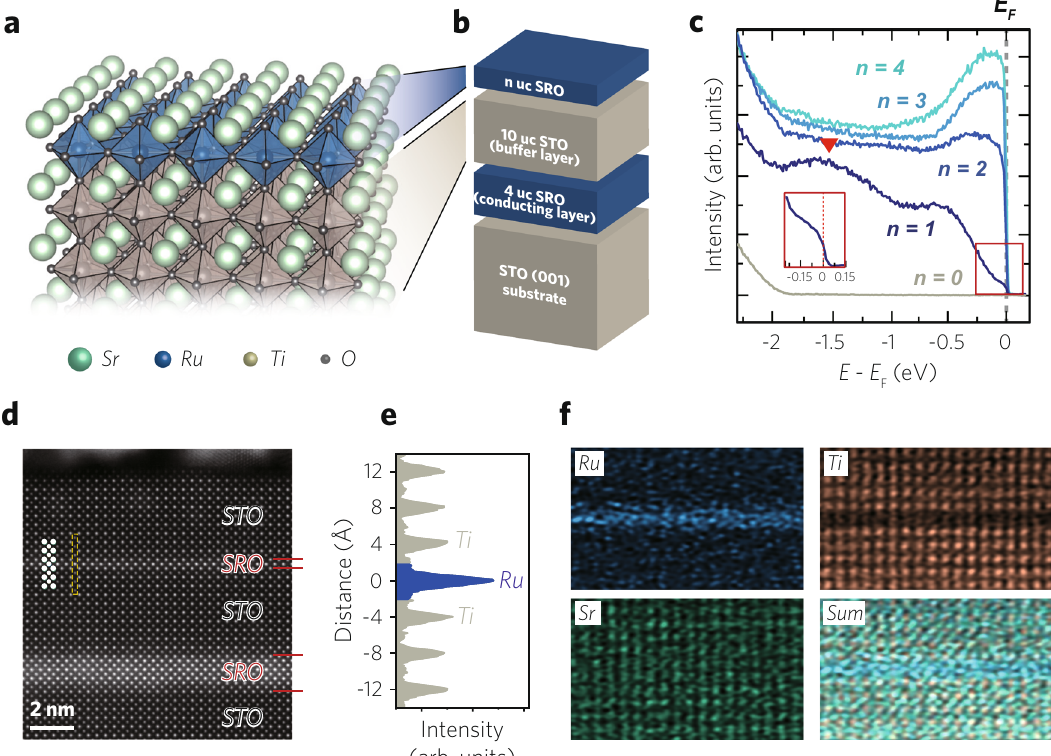
Fig. 1 Observation of a metallic single-atomic-layer oxide in charging-free ultrathin SrRuO 3 (SRO) heterostructures. a A schematic of a monolayer SRO grown on a (001)-oriented SrTiO 3 (STO) layer. b A schematic of a charging-free ultrathin SRO heterostructure composed of 4 unit-cell (uc) SRO layer (conducting layer), 10 uc STO layer (buffer layer), and n uc ultrathin SRO layer, sequentially grown on an STO (001) substrate. The conducting layer prevents the charging effect during the photoemission measurement. The buffer layer decouples the electronic structure of the ultrathin SRO layer from that of the conducting layer. c Angle-integrated photoemission spectra from charging-free ultrathin SRO heterostructures. Energy distribution curves (EDCs) are integrated in the range of − 0.6 Å − 1 ≦ k y ≦ 0.6 − 1 and k x = 0. n indicates the number of SRO layers. The Fermi edge is persistently seen down